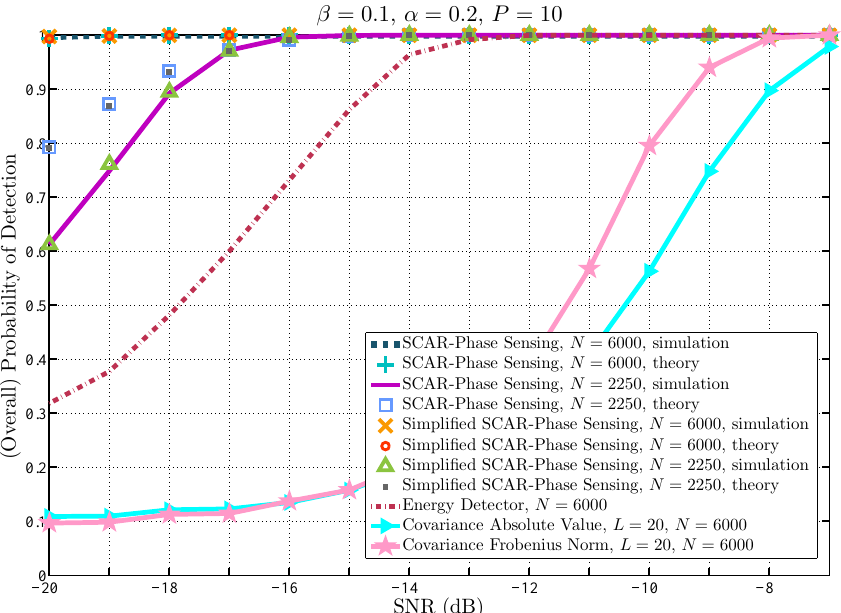
Figure 7. Comparison of the (overall) probability of detection against SNR for different spectrum sensing